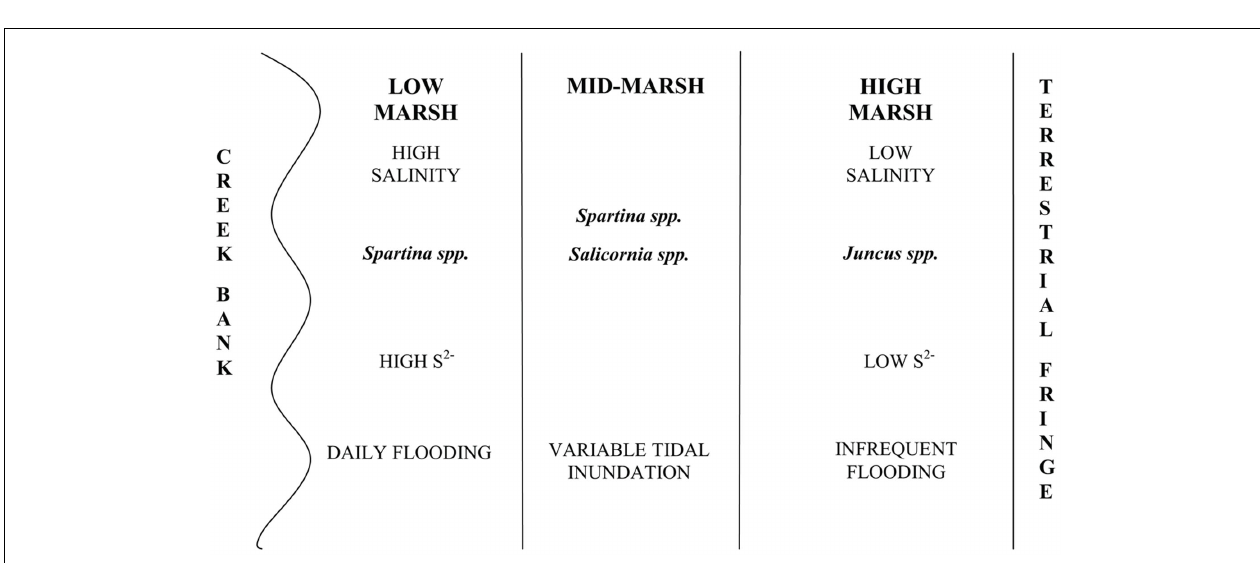
et al., 2001; Bergholz et al., 2001). Diazotrophs associated with salt marsh macrophytes, particularly the cordgrasses ( Spartina